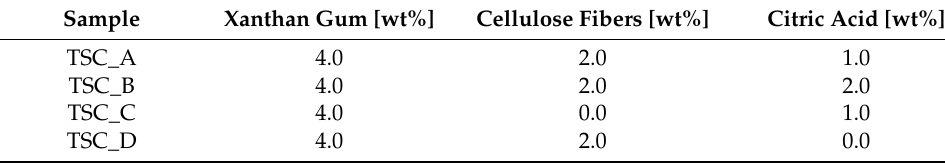
Table 3. List of prepared the xanthan gum-based films, used as